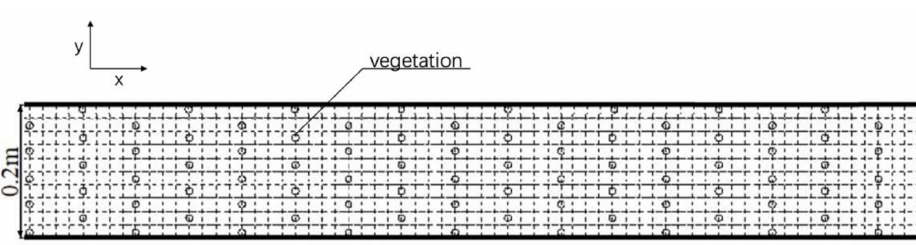
Figure 2. Different types of vegetation: ( a ) reed, ( b ) stick, ( c ) grass, ( d ) chlorella.